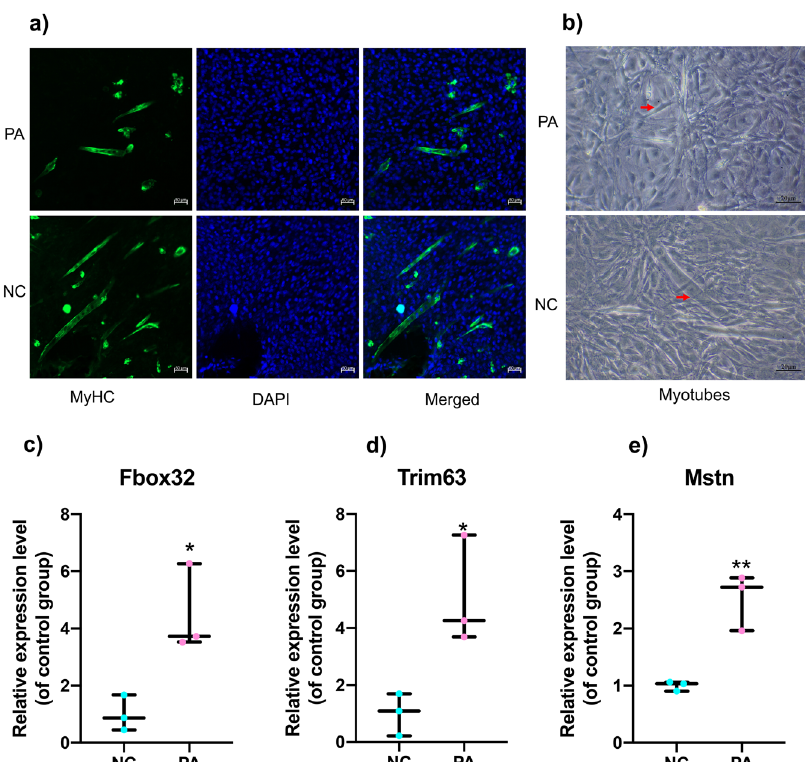
Fig. 5 PA-induced muscle atrophy model in C2C12 cells. The decreased CSA and numbers of myotubes were observed in PA-treated C2C12 cells through fl uorescently labeled MyHC by confocal microscopy ( a ) and light microscopy ( b ). The higher expression of Fbox32 ( c ), Trim63 ( d ), Mstn ( e ) suggested that PA-induced muscle atrophy in C2C12 cells. Data were expressed as mean ± S.D. * P < 0.05 ** P < 0.01. Note: PA: palmitic acid; MyHC: myosin heavy